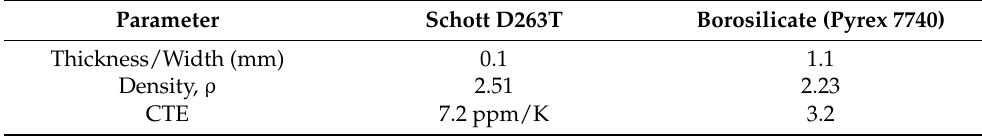
Table 1. Optical properties of 0.1 Schott glass and 1.1 mm borosilicate glass